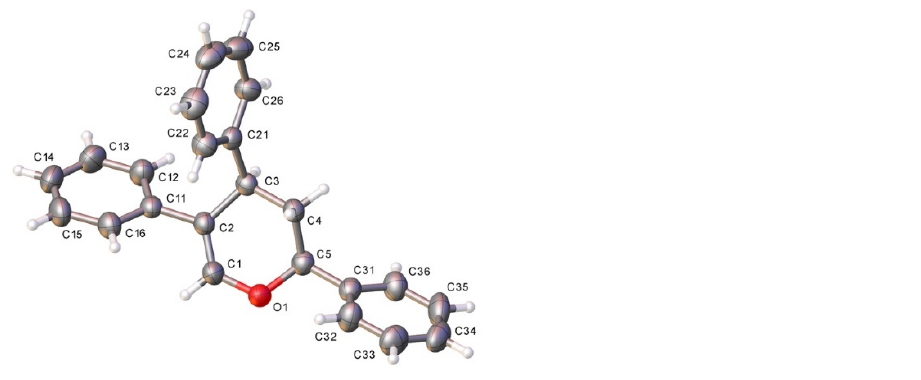
Figure 3. X-ray crystal structure of 9 ; displacement ellipsoids at 50% probability. Colour key: C (grey), N (blue), O (red), Si (orange). CCDC: 2118174 [19].